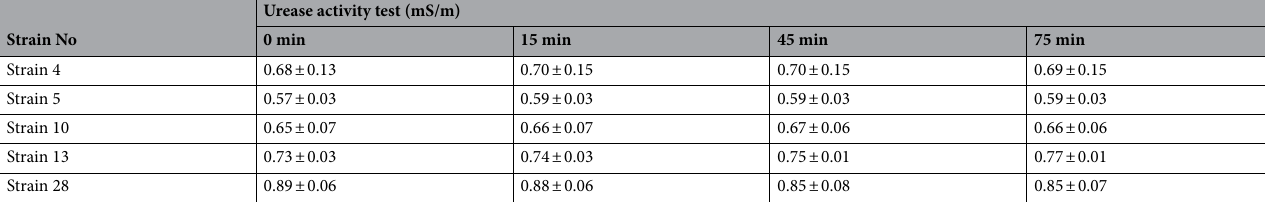
Table 1. Results of urease activity test in terms of electrical conductivity